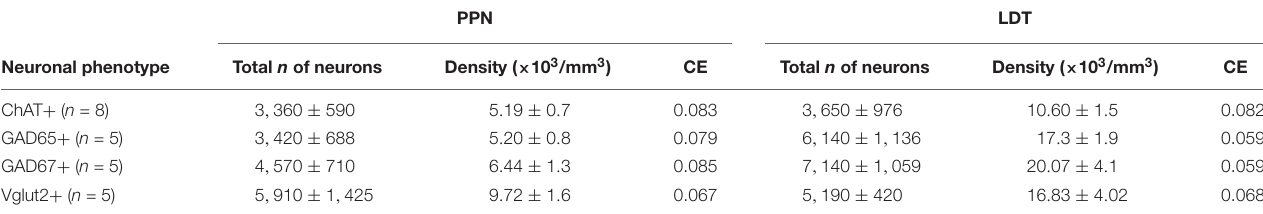
TABLE 3 | Estimated number of neurons and neuronal densities of the different cell phenotypes in the PPN and LDT.